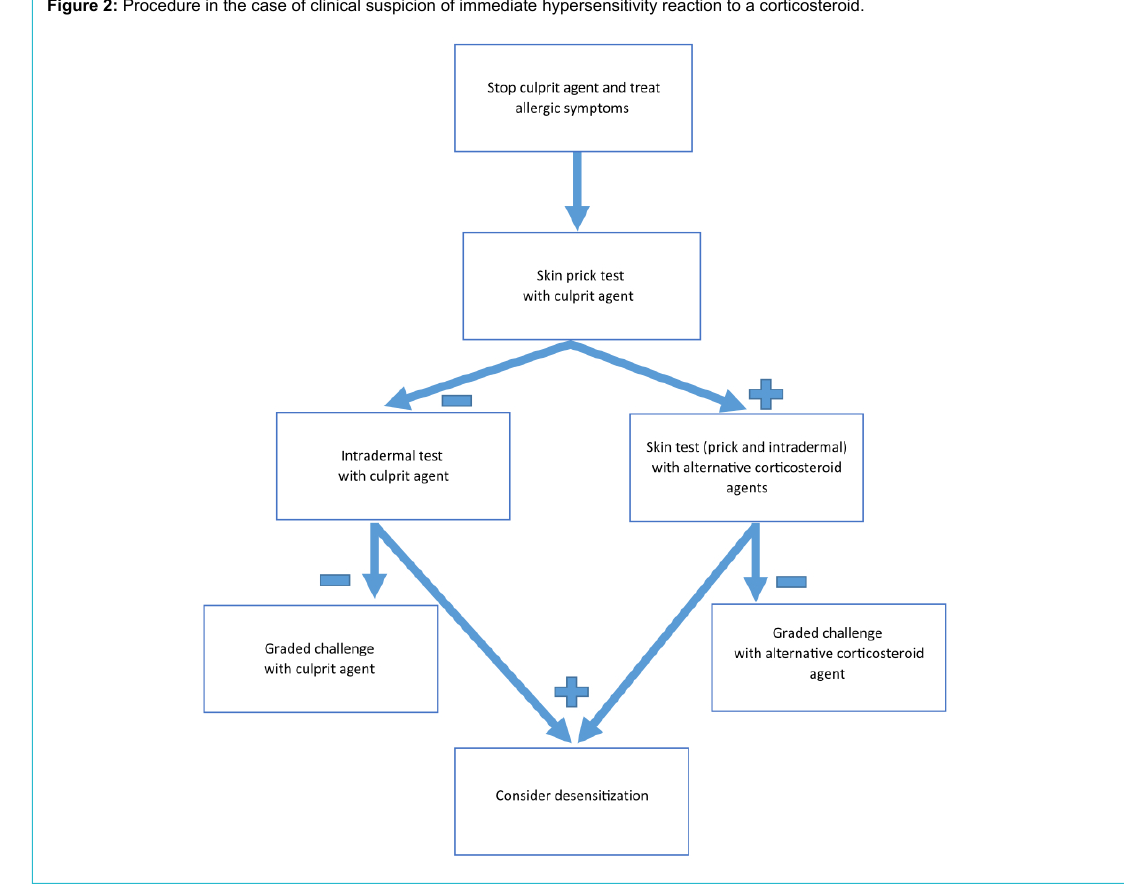
Figure 2: Procedure in the case of clinical suspicion of immediate hypersensitivity reaction to a